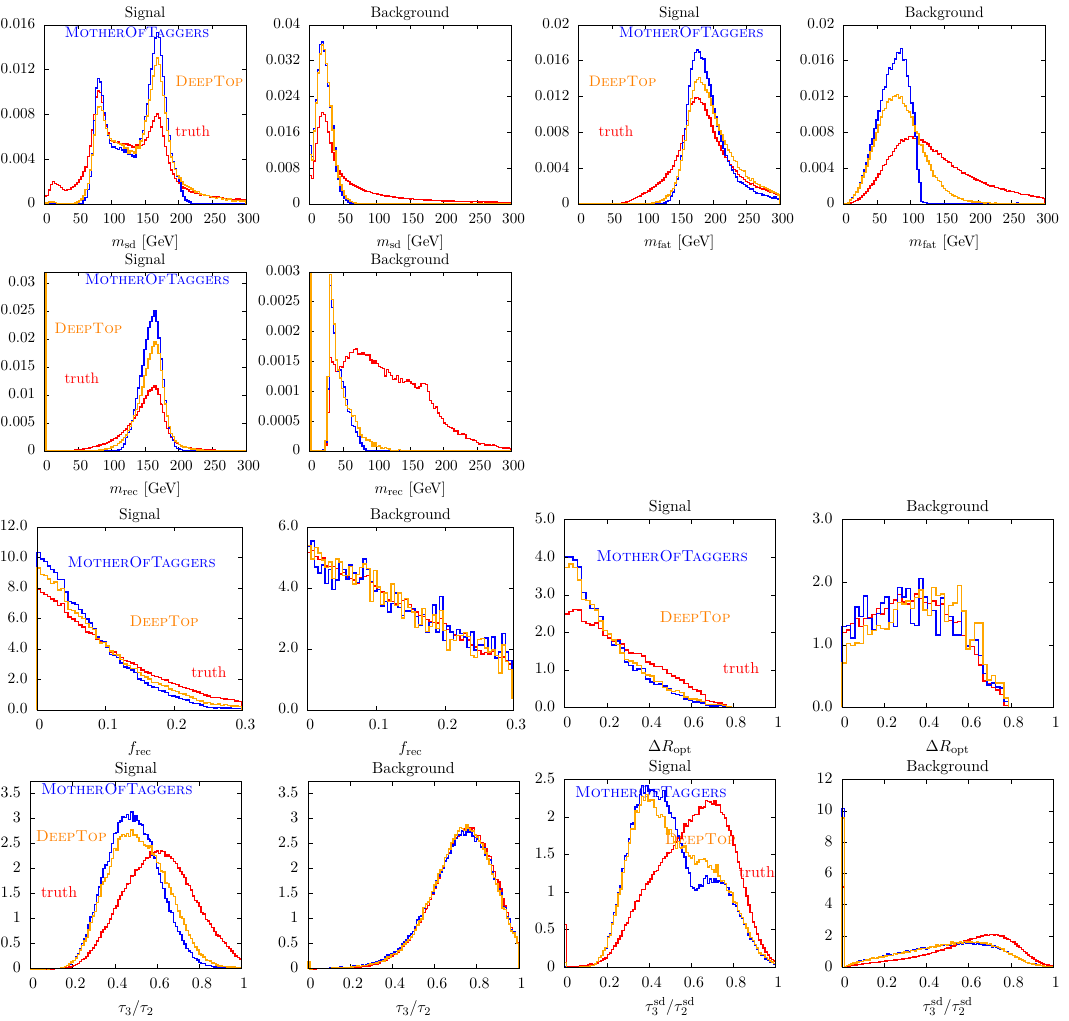
Figure 10 . Kinematics observables de(cid:12)ned in eq. (3.5) for events correctly determined to be signal or background by the DeepTop neural network and by the MotherOfTaggers BDT, as well as Monte Carlo truth. Extended version of (cid:12)gure